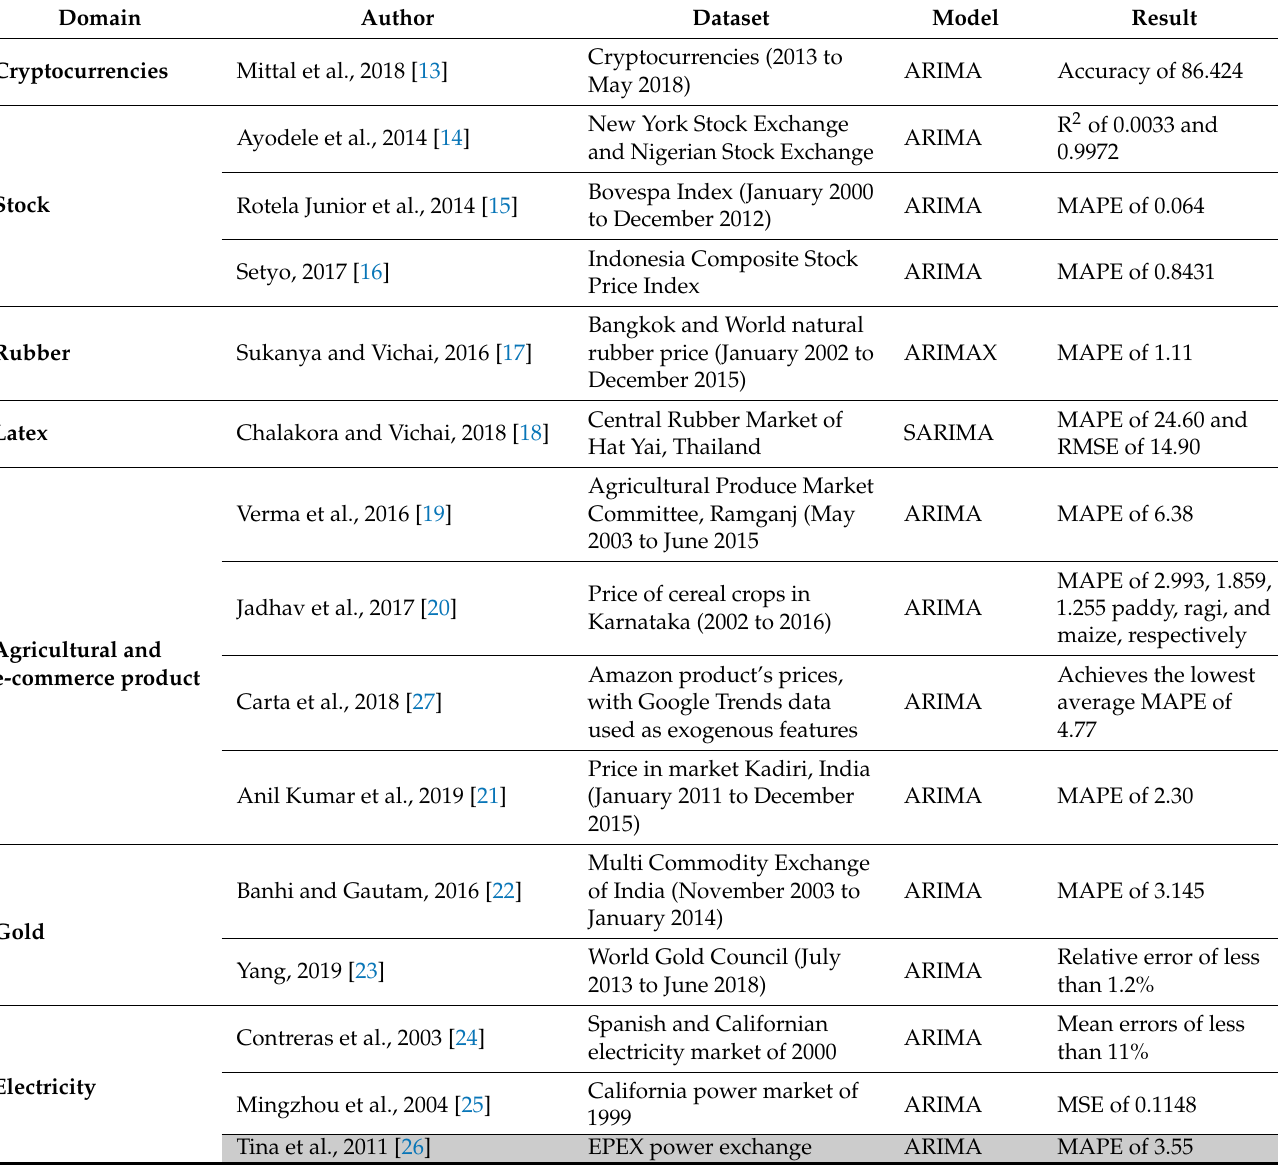
Table 2. ARIMA time-series forecasting from 2003 to